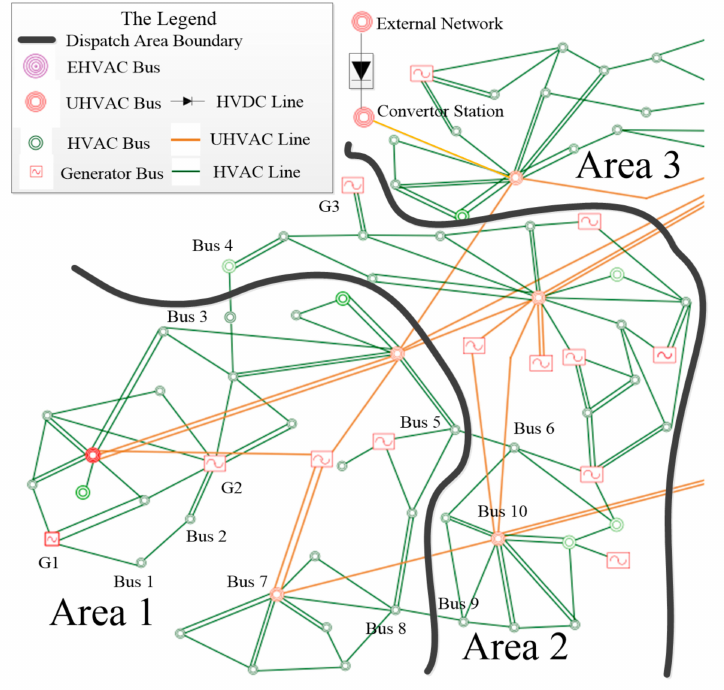
Figure 4. Detailed dispatch areas of a partial power